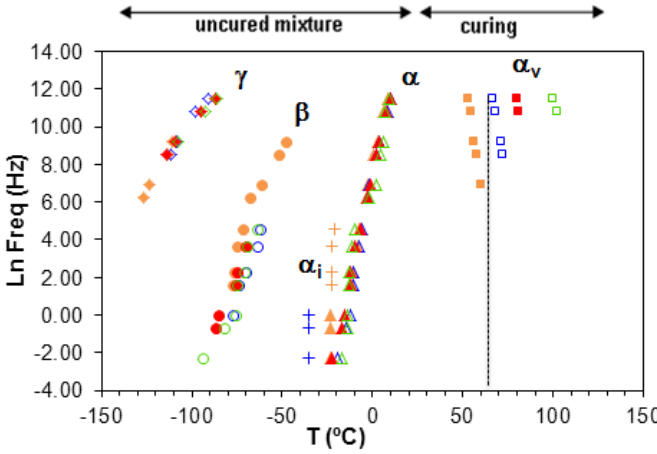
Figure 12. Temperatures of the relaxations peaks for the ELP sample at different heating rates: 0.5 K/min, orange filled symbols; 1 K/min, blue open symbols; 2 K/min, red filled symbols; 4 K/min, green open symbols. The vertical dashed line shows the vitrification temperature obtained by TOPEM at 0.5 K/min.